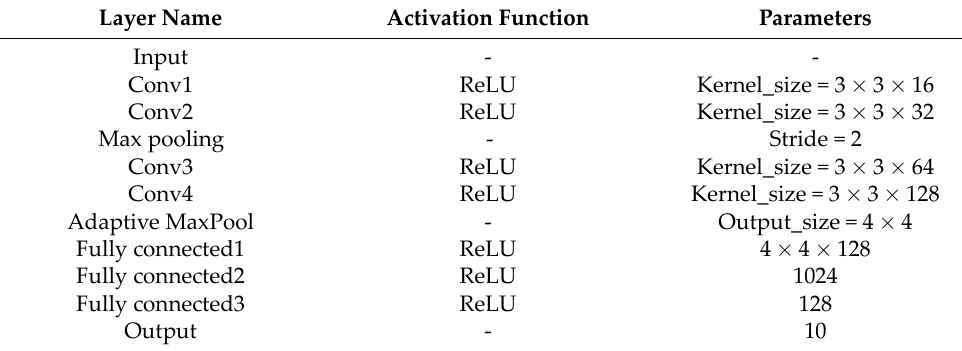
Table 3. Information of CNN structure.